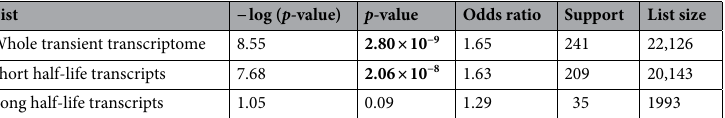
Table 1. Enrichment of MS-associated genetic variants in lists of T-cell transient transcripts extracted from Michel et al., 2017. The whole transcriptome list was split in two sub-lists depending on the transcripts’ half- life: short (< 60 ′ ) and long (≥ 60 ′ ), respectively. Results are considered significant at p < 0.05 and are highlighted in bold.